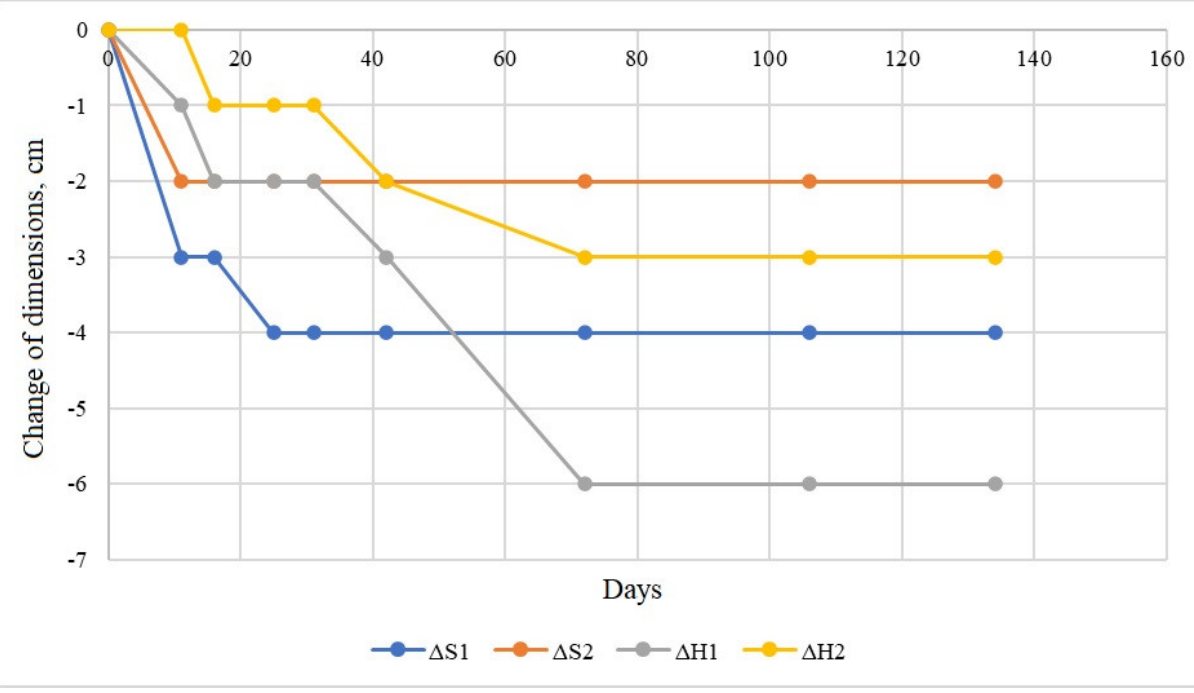
Figure A7. Change of the roadway dimensions—convergence control station no. 3.